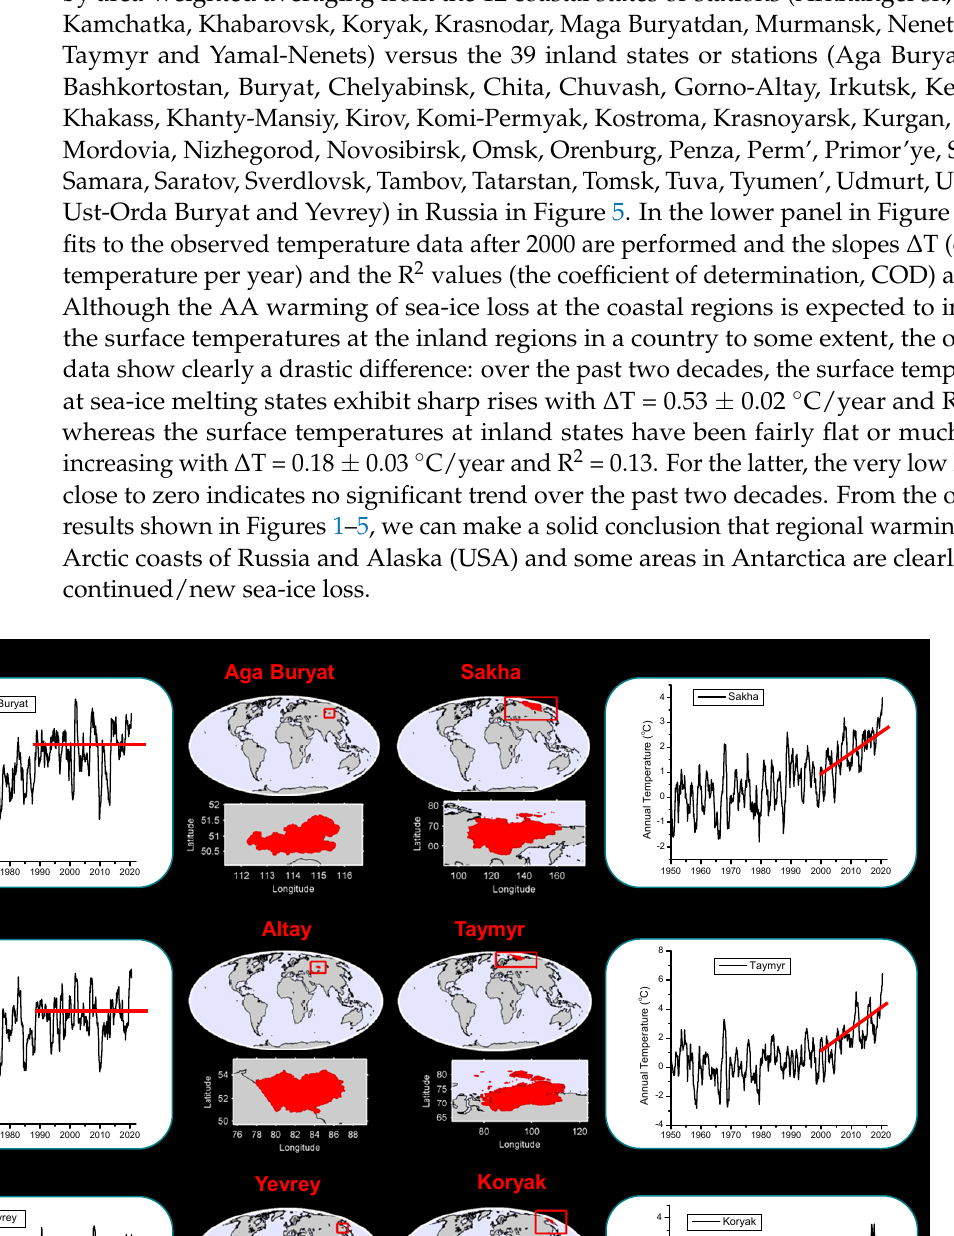
Figure 5. (Upper panel) Time-series annual surface temperatures of three representative inland states (Aga Buryat, Altay and Yevrey) that have no sea-ice melting versus three representative coastal states or observation stations (Sakha, Taymyr and Koryak) in which sea-ice melting occurs in Russia (the red lines roughly showing the change trends). (Lower panel) Time-series annual, 5- year and 10-year mean surface temperatures averaged from the 39 inland states or stations with no sea-ice melting versus the 12 coastal states or stations in which sea-ice melting occurs in Russia (see the text), where linear fits to the observed data after 2000 are given (the violet lines), with the slopes Δ Ts (changed temperatures per year) and the R 2 (COD) values indicated.